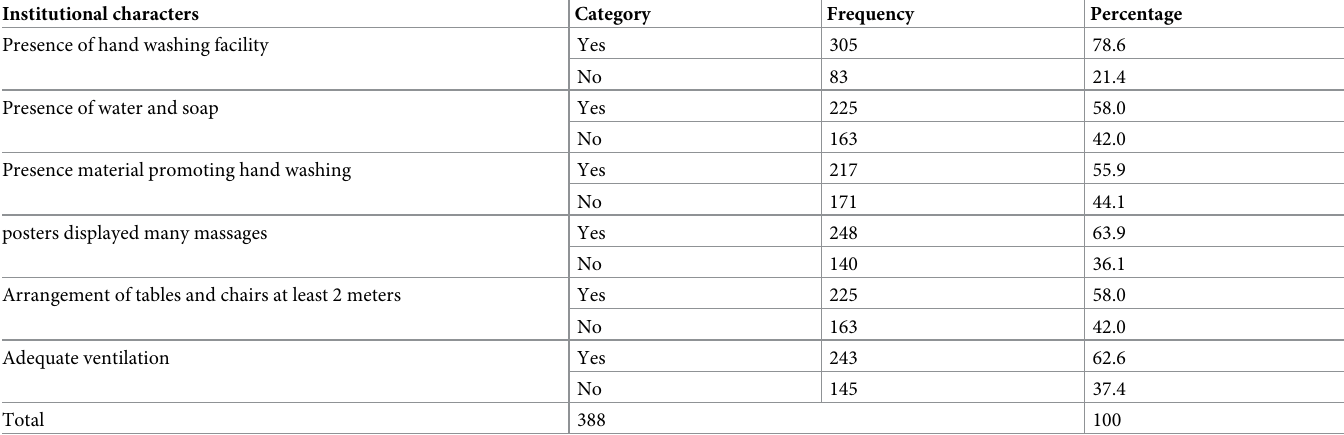
Table 4. Institutional factors of COVID-19 preventive practice among Jimma high schools 2021 (n = 388). Institutional